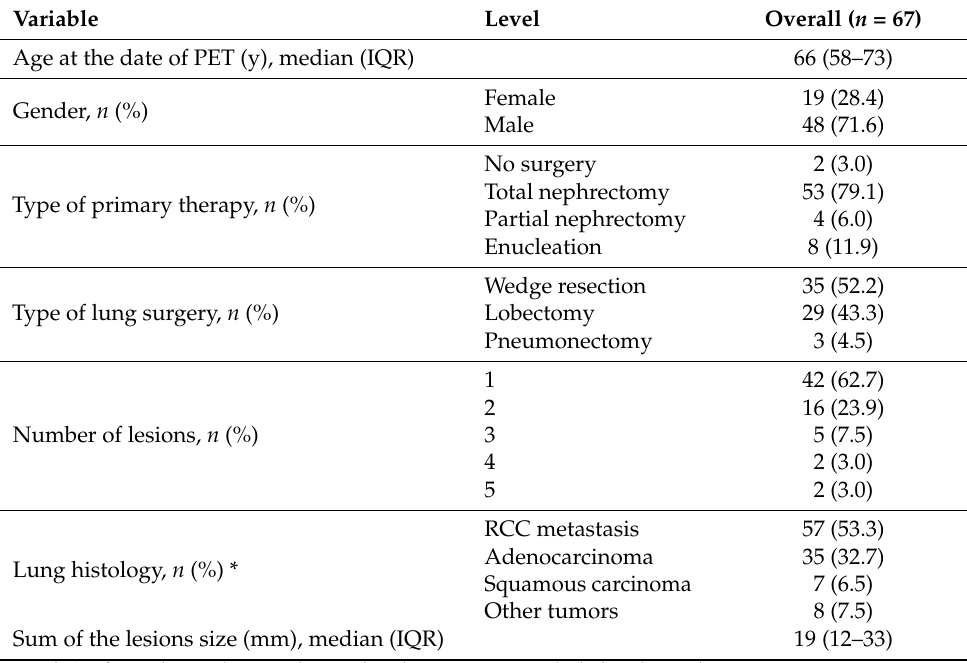
Table 1. Demographic, tumor and treatment characteristics of the study population ( n = 67).